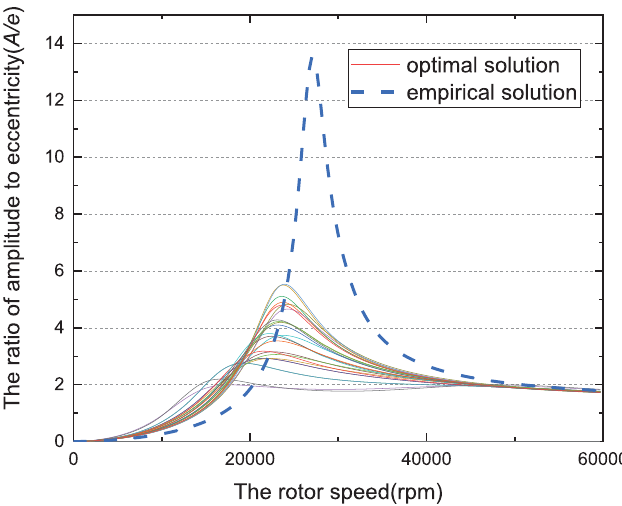
Fig. 3. Rotor imbalance response before and after optimization